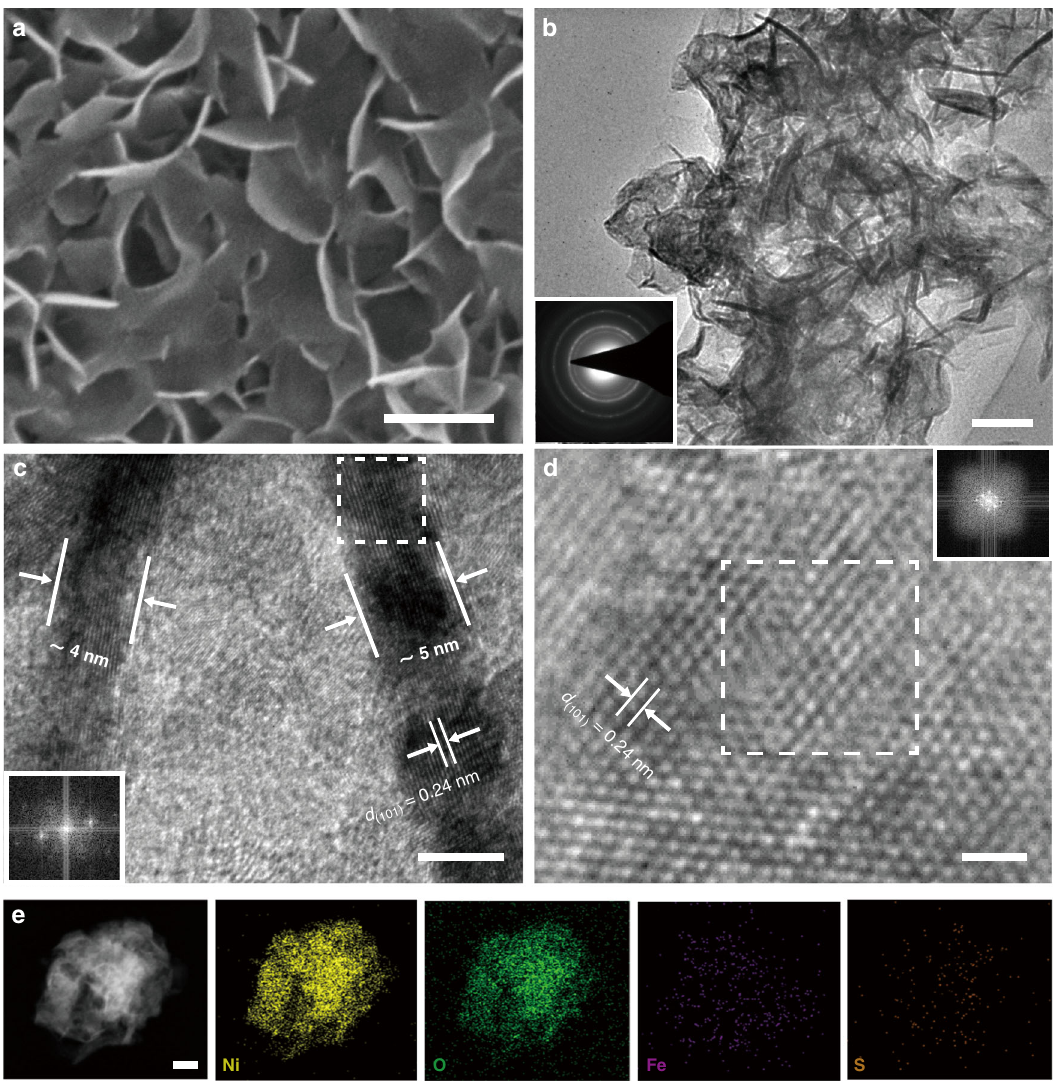
Fig. 2 Structural characterizations of Ni(Fe)OOH – FeS x . a FESEM image, scale bar: 200 nm. b TEM image and corresponding SAED pattern (inset), scale bar: 50 nm. c , d HRTEM images and corresponding FFT patterns (insets), scale bars: 5 nm ( c ) and 1 nm ( d ). e corresponding elemental mappings, scale bar: 50